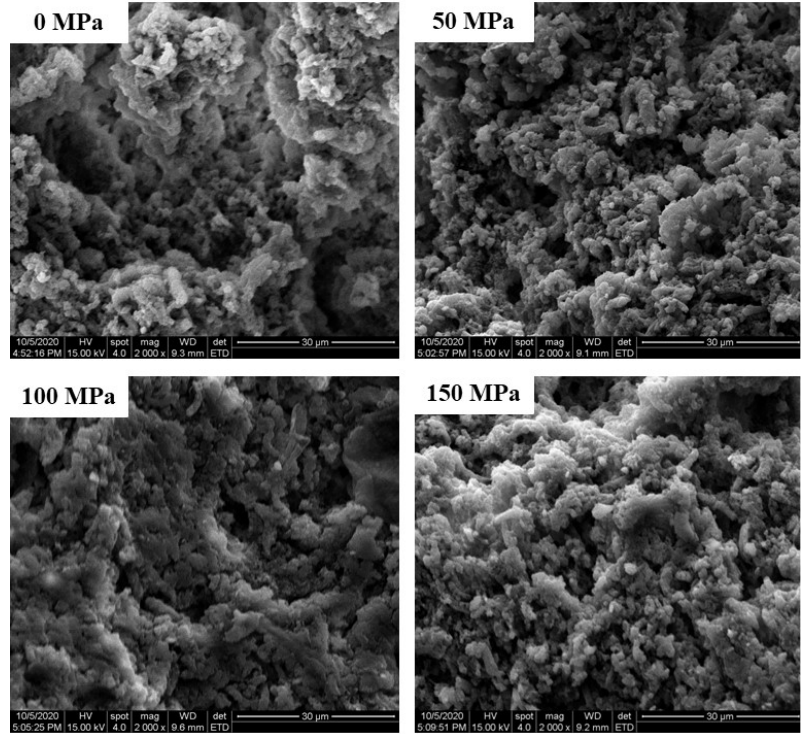
Figure 4. The microstructure of cooked pork myofibrillar protein with high-pressure homogenization-modified soy 11S globulin.